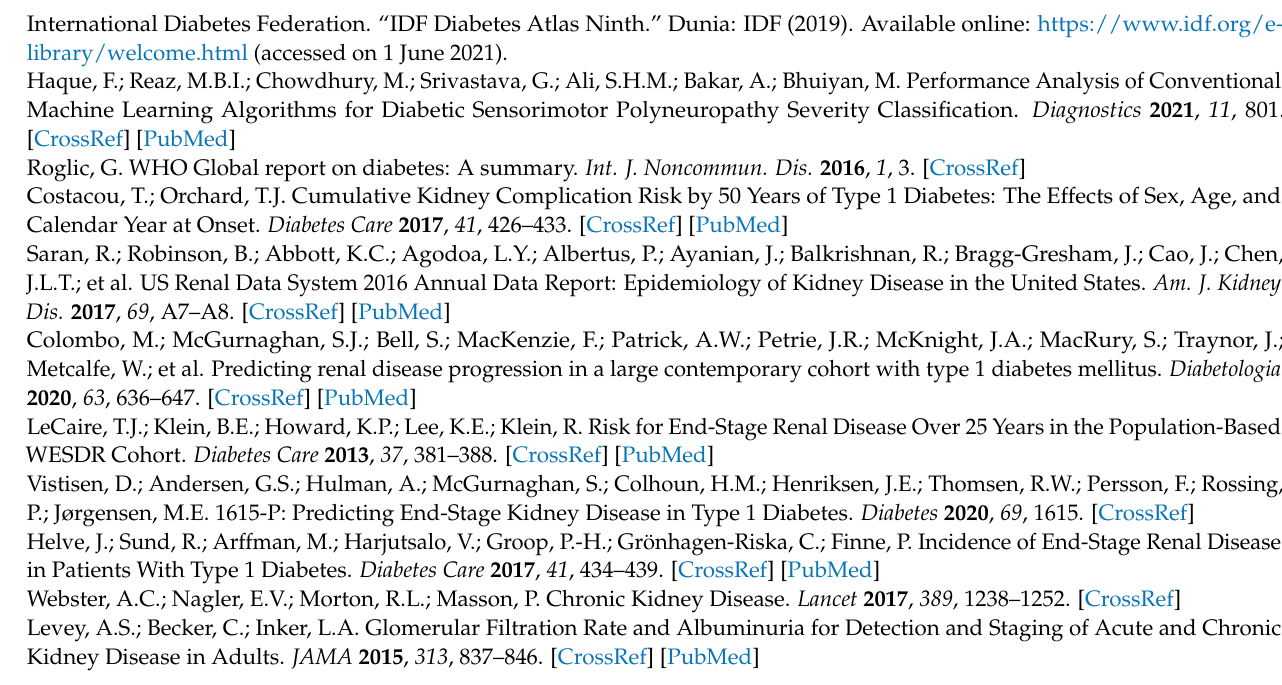
Table S8. Performance analysis of RF algorithm using KNN data imputation and XGB feature ranking; Table S9. Performance analysis of XGB algorithm using KNN data imputation and Extra Tree feature ranking; Table S10. Performance analysis of LightGBM algorithm using KNN data imputation and XGB feature